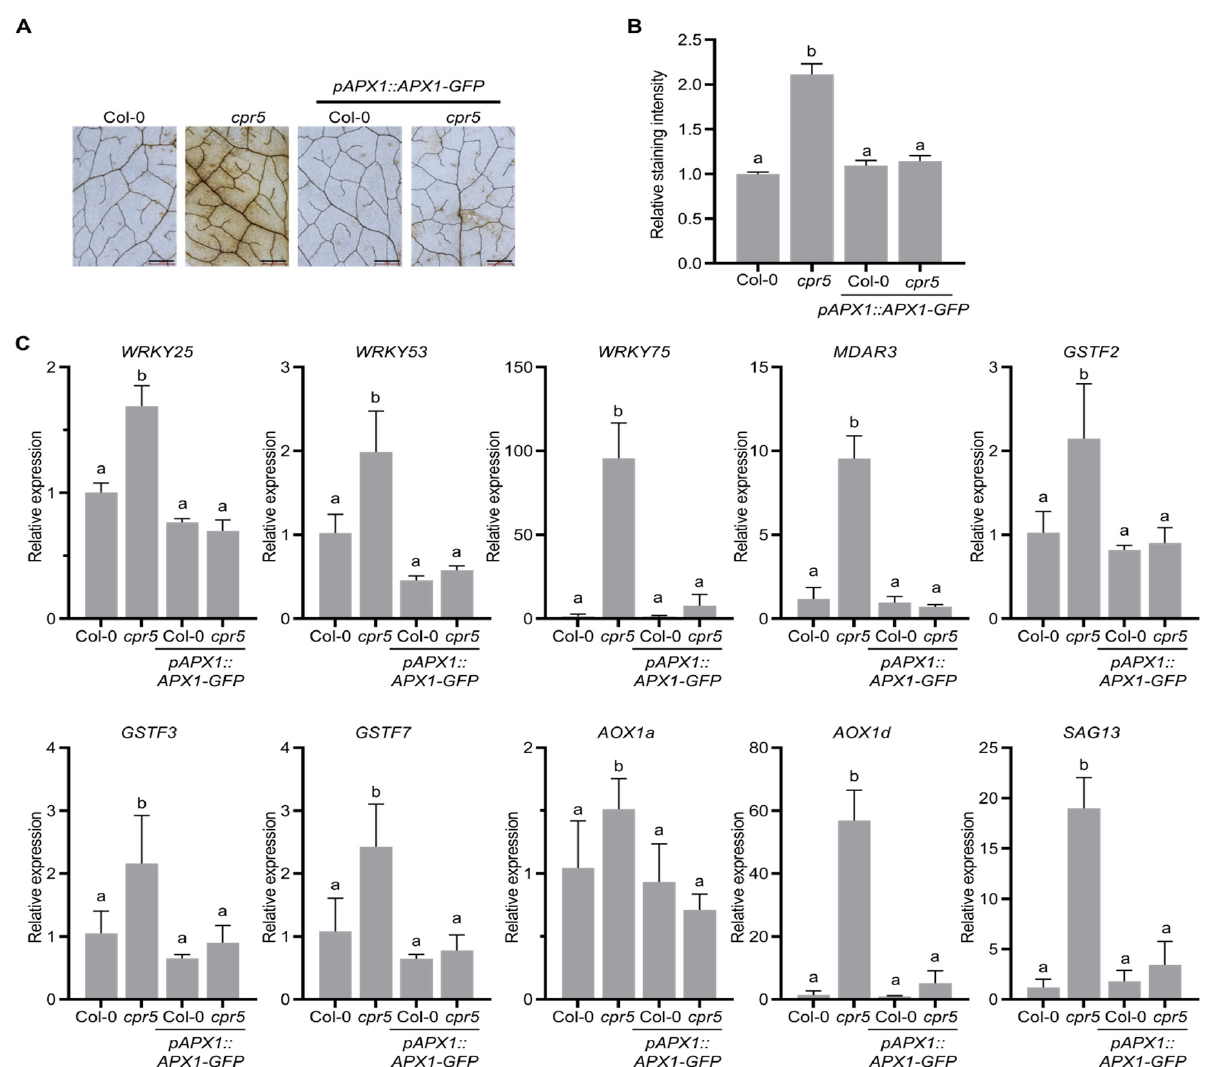
Figure 5. APX1 overexpression in cpr5 mutants removes excessive ROS. ( A ) APX1 overexpression removed excessive ROS accumulation in cpr5 mutants. ROS accumulation was detected by DAB staining. The 5th–7th rosette leaves on 4-week-old plants were detached and stained with DAB solution. ROS production was visualized as dark brown precipitate in detached leaves. Representative leaves are shown. Scale bars = 2 mm. ( B ) Quantification of DAB staining intensity in ( A ). Relative DAB staining intensity per unit leaf area was measured using the ImageJ software. Data are means ± SE (n = 10). Letters above bars indicate significantly different values among groups ( p ≤ 0.05; one-way ANOVA). ( C ) APX1 overexpression in cpr5 mutants restores elevated ROS-related gene expression. Total RNA was extracted from 4-week-old leaves. ACTIN7 served as the reference gene. Data are the mean ± SD (n = 4). Letters above bars indicate significantly different values among groups ( p ≤ 0.05; one-way